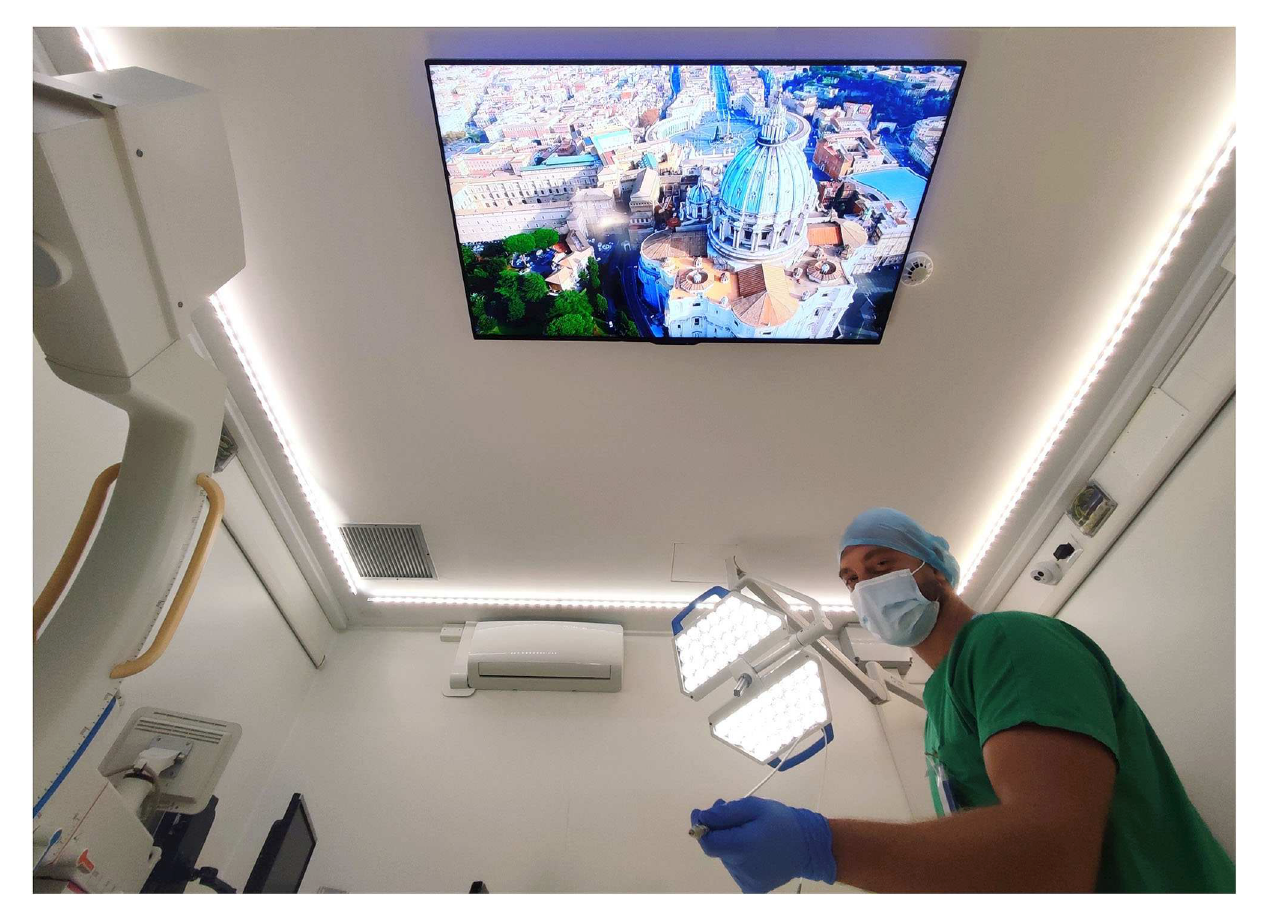
FIGURE3 Interventional oncology center room (MISSION: Multisensory Integrated SyStem for patIent cOmpliaNce